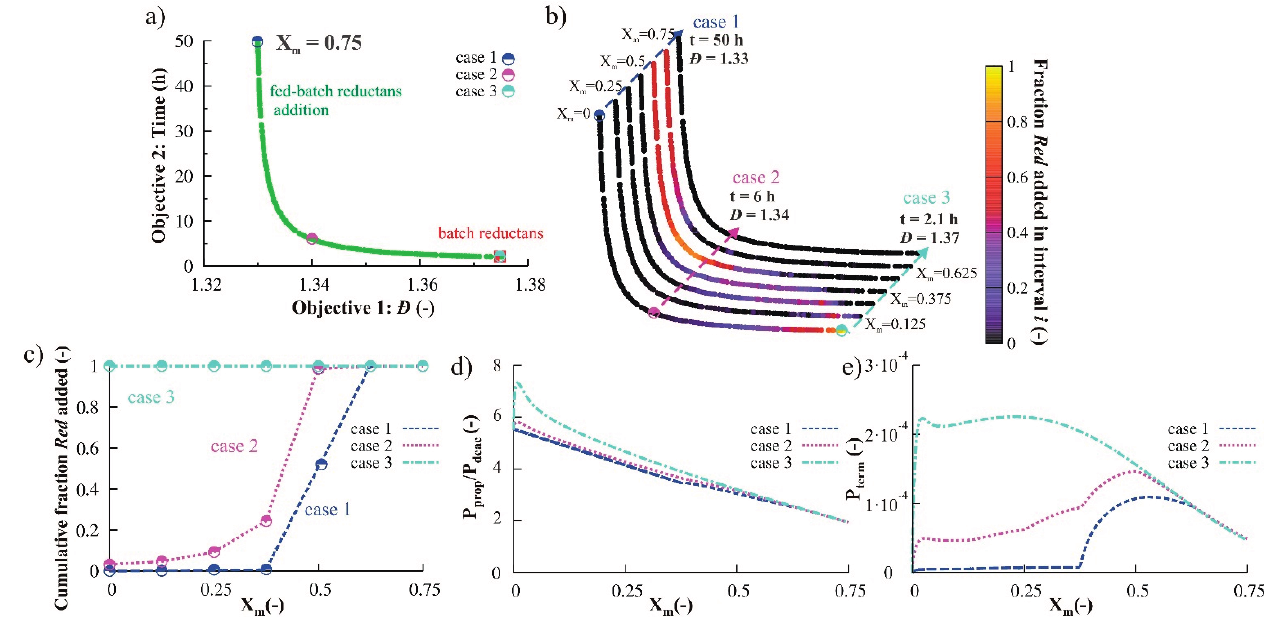
Figure 5. Results for the multi-objective optimization (MOO) of ARGET ATRP of MBA using a fed-batch reducing agent program (constant molar flow rate per Δ X m = 0.125 until X m = 0.75; [ M ] 0 /[ R 0 X ] 0 /[ Cu II X 2 / L ] 0 = 200/1/0.005; 90 °C: batch case: [ R 0 X ] 0 /[ Sn II (EH) 2 ] 0 = 0.05). ( a ) Pareto-optimal front (green circles) and reference batch case (red square); ( b ) Variation of the seven variables (fraction reducing agent added initially (variable 1) and during a certain conversion interval (variable 2–6)) along the Pareto-optimal front; ( c ) Cumulative fraction of reducing agent added as a function of X m for three selected cases in (a); ( d ) Ratio of probability of propagation to deactivation as a function of X m for the selected cases; ( e ) Probability for termination as a function of X m for the selected